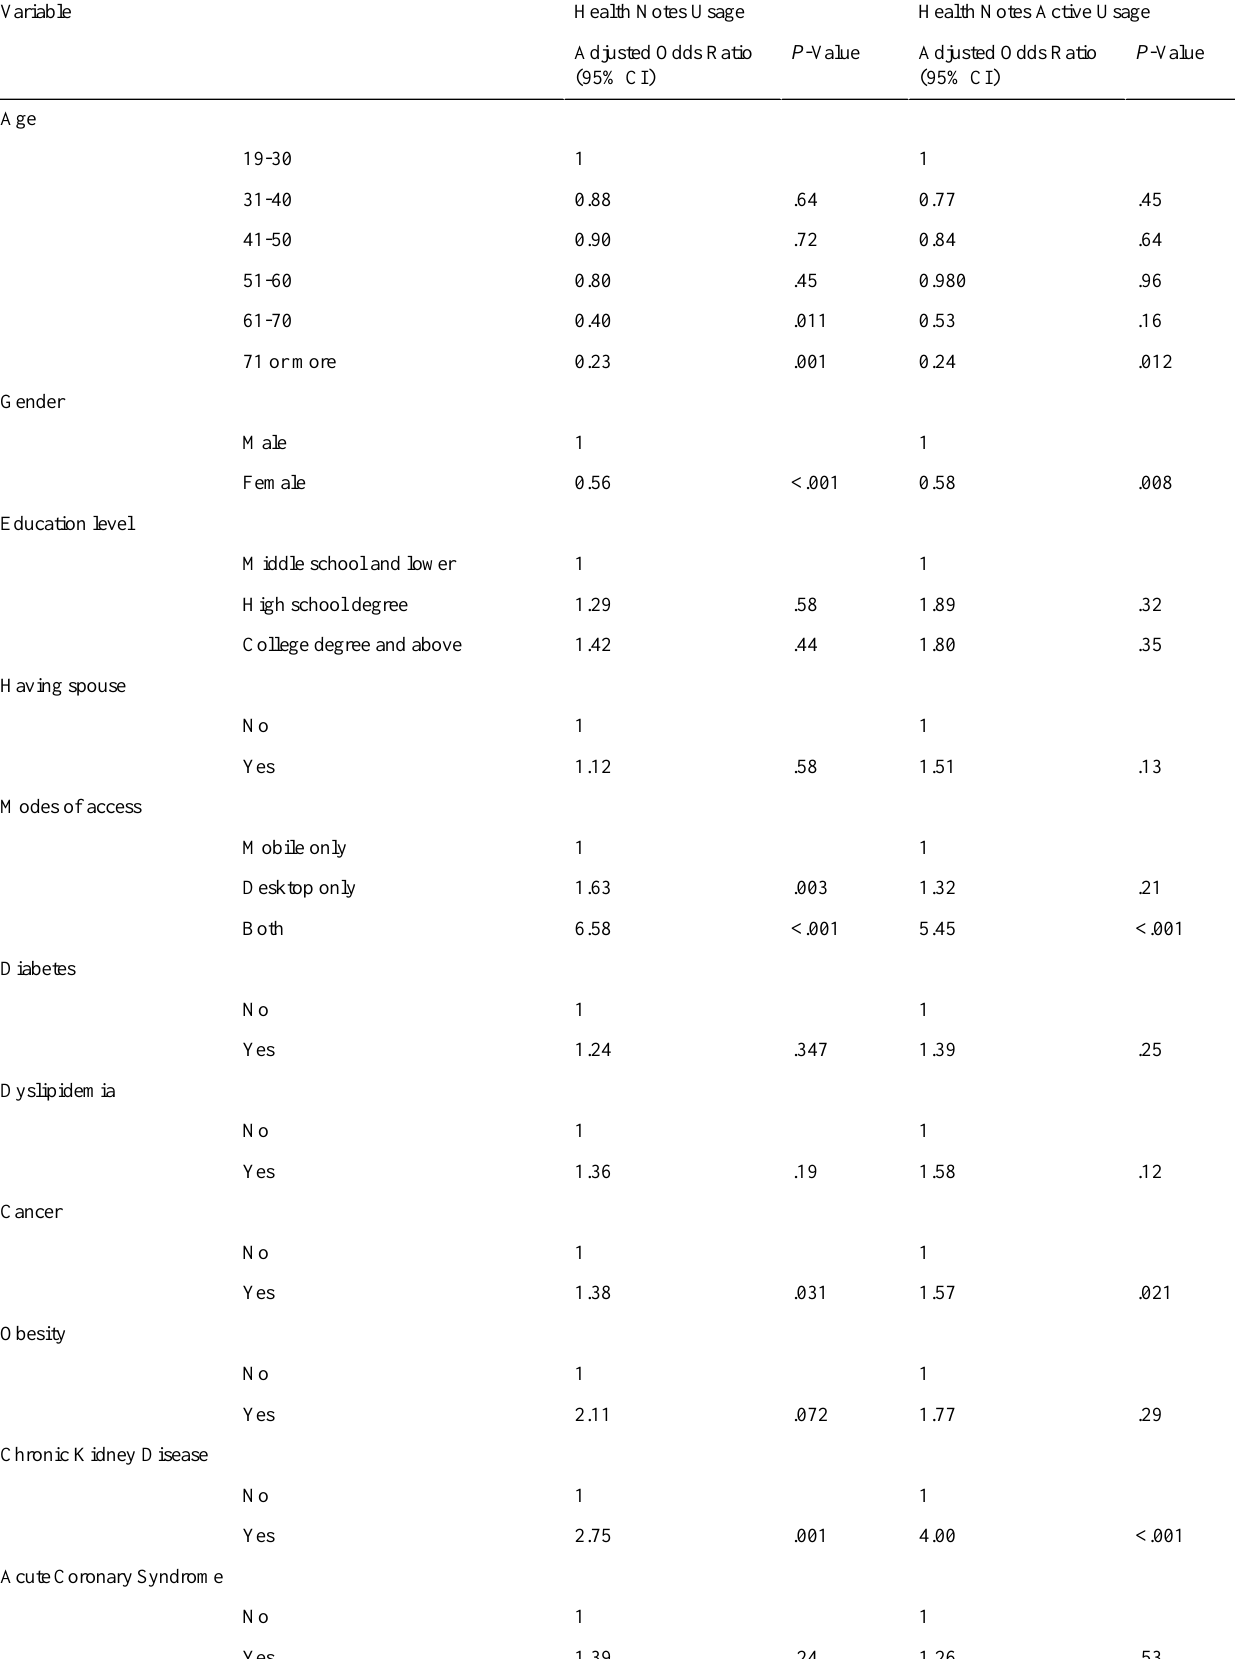
Table 3. Multivariable analysis of the factors associated with completing the health notes in Health4U (Model